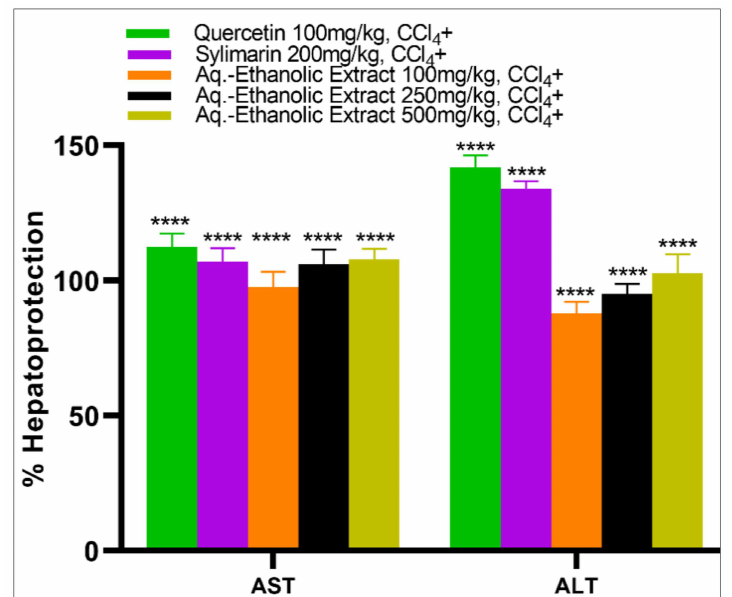
Figure 2. The hepatoprotective e ff ects of Suaeda vermiculata aq.-ethanolic extract on CCl 4 induced liver toxicity. Percentage protection of CCl 4 induced elevation of AST and ALT enzymes. The protection percentage formula assumes the enzyme level of the CCl 4 administered negative group (carboxyl methylcellulose) at 0% protection and that of intact group (no exposure to CCl 4 ) at 100% protection as such they are excluded from the graphical representation. In addition, the aq.-ethanolic extract 250mg / kgCCl 4 -thegroupwhichdidnotreceiveCCl 4 -isalsoexcludedfromthegraphicalrepresentation. **** Data di ff ered significantly at p < 0.0001 when compared with the negative control group. Values are expressed as mean ± SEM, n = eight rats per group, CCl 4 -: Carbon tetrachloride was not administered. CCl 4 + : Carbon tetrachloride-induced liver toxicity.